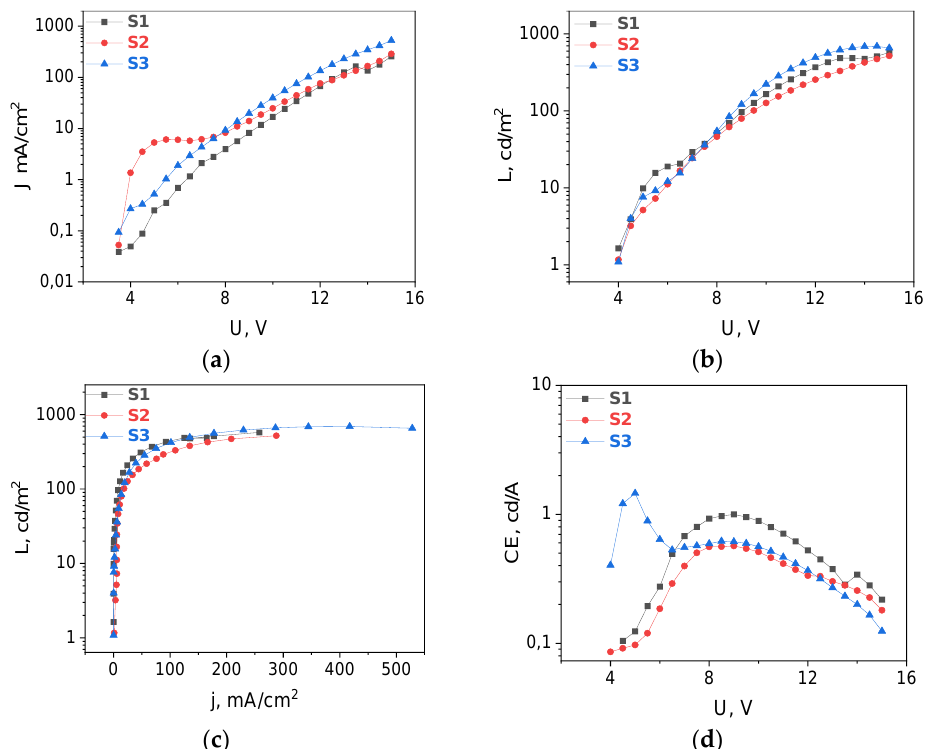
Figure 5. ( a ) J-V, ( b ) L-V, ( c ) L-J, and ( d ) CE-V curves of Eu(dik) 3 DPPZ:CBP 1:3 thin films: dbm (blue), btfa (red), and tta (black).